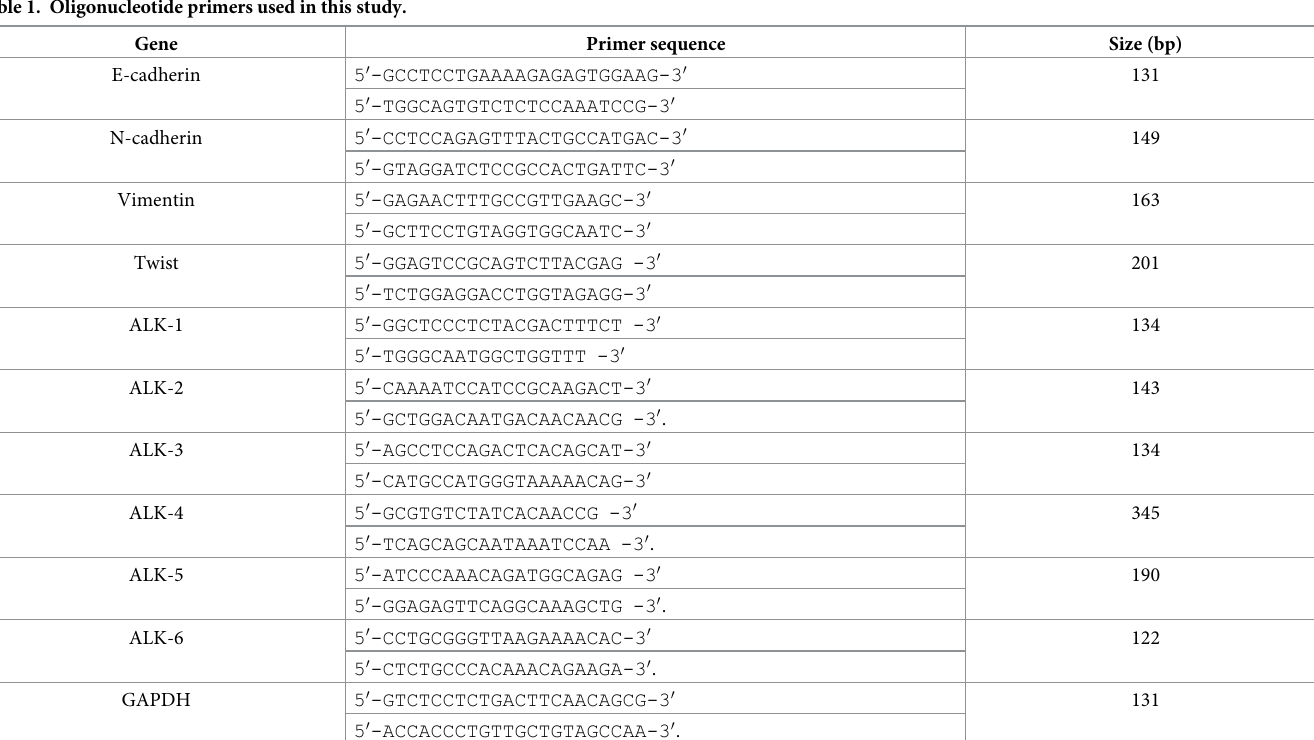
Table 1. Oligonucleotide primers used in this study.